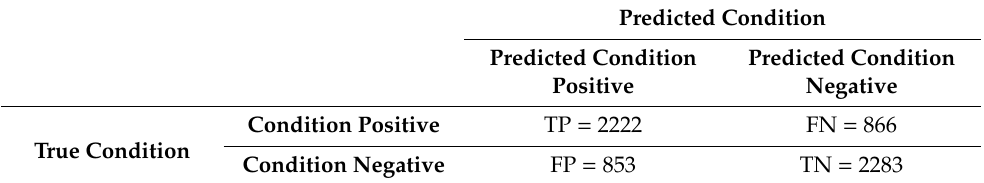
Table 7. Confusion matrix for NB. (TP: true positive, TN: true negative, FN: false negative, FP: false positive).